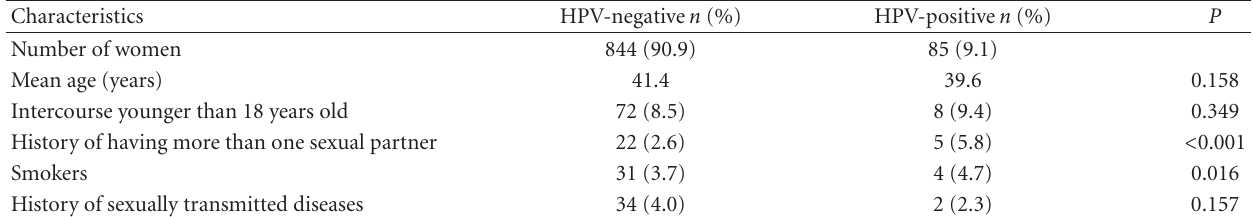
Table 1: Risk factors for HPV infection between HPV-negative and HPV-positive women.